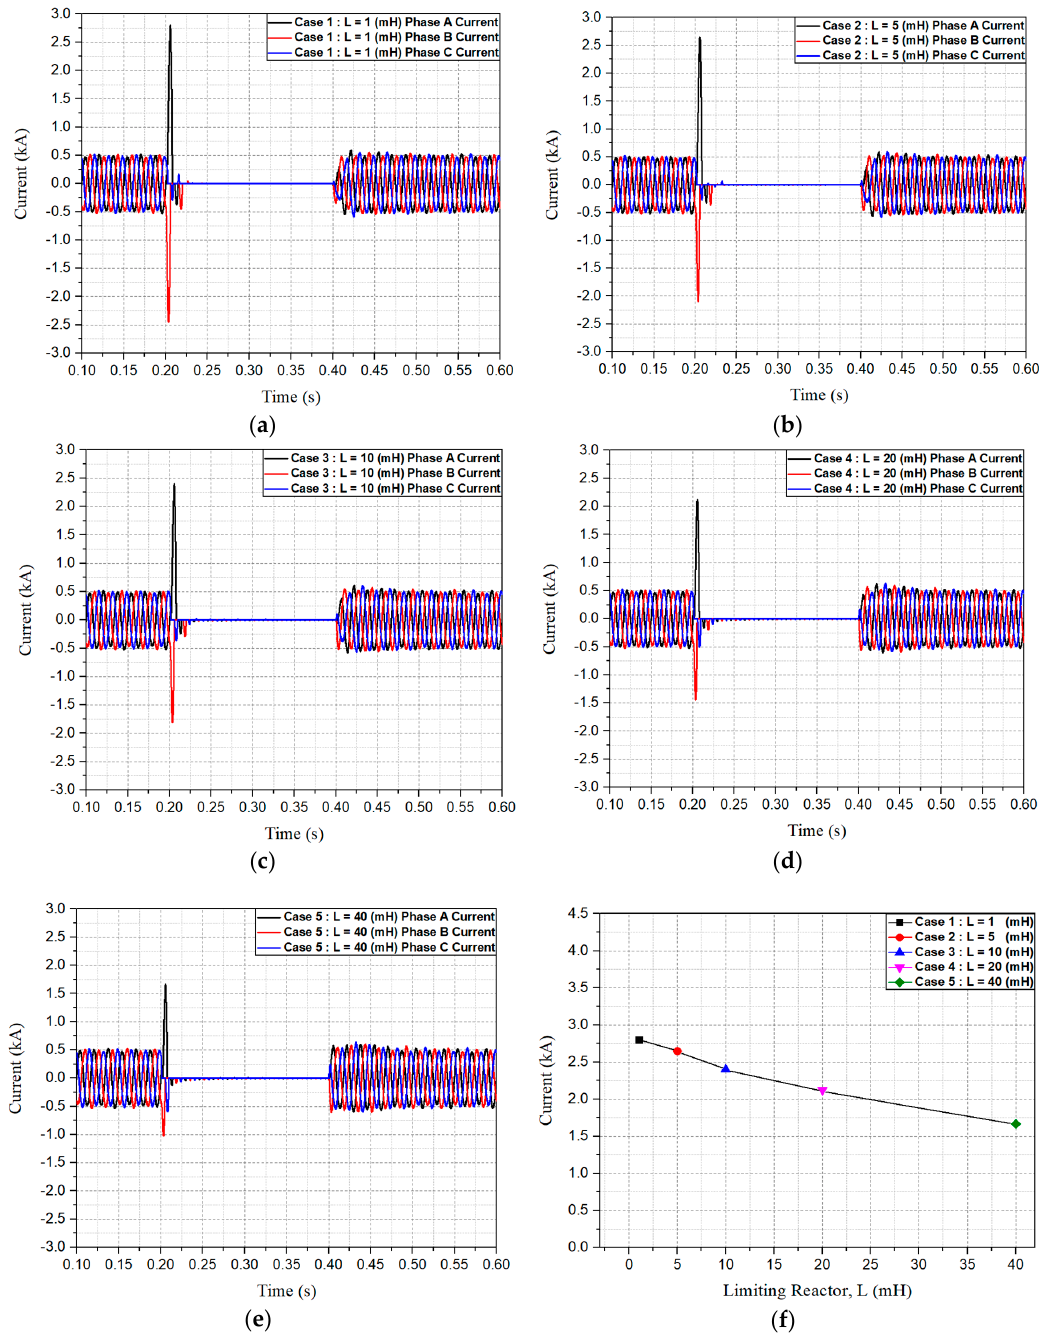
Figure 8. The transient current waveforms of the AC system considering the variable current limiting reactor: ( a ) Case 1: L = 1 (mH); ( b ) Case 2: L = 5 (mH); ( c ) Case 3: L = 10 (mH); ( d ) Case 4: L = 20 (mH);